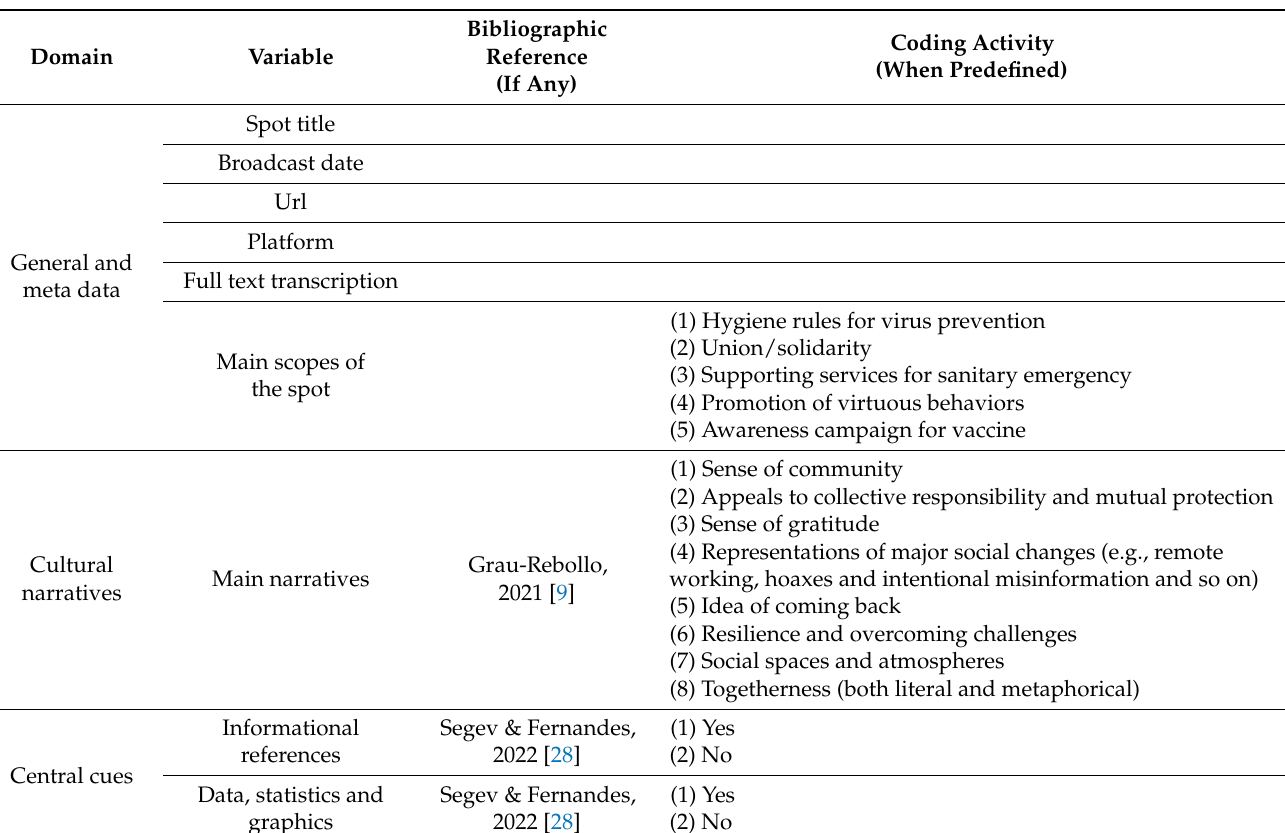
Table 2. The codebook